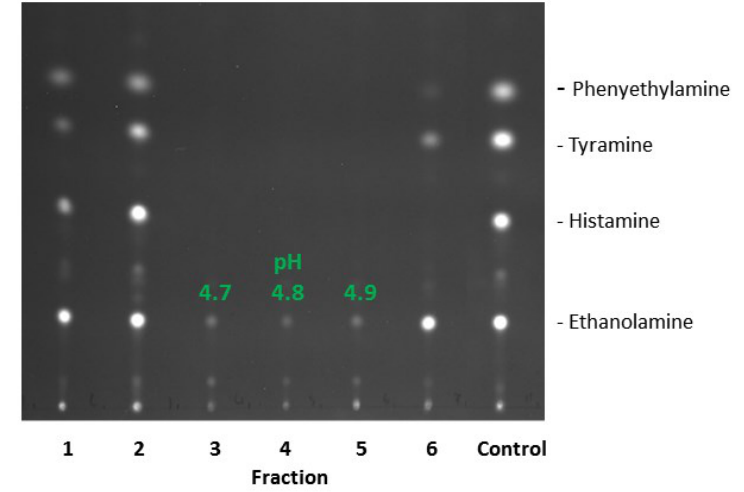
Figure 5. Degradation of BA by a cell-free extract (S3) from D. hansenii H525 as detected by TLC. Six fractions of S3 obtained after pIEF were incubated with 0.25 mM BA for 24